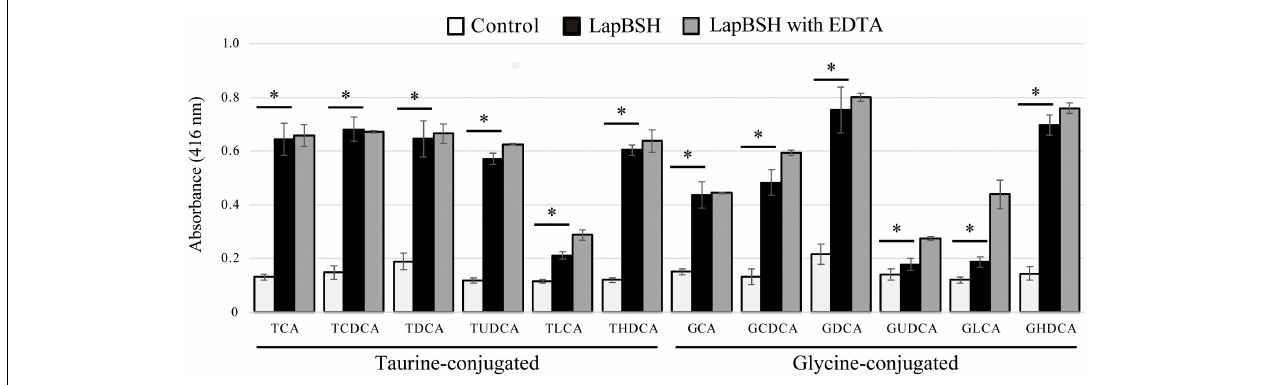
FIGURE 1 | Bile salt hydrolase (BSH) activity and substrate specificity of LapBSH. The tested substrates were glycocholic acid (GCA), glycochenodeoxycholic acid (GCDCA), glycodeoxycholic acid (GDCA), glycoursodeoxycholic acid (GUDCA), glycolithocholic acid (GLCA), glycohyodeoxycholic acid (GHDCA), taurocholic acid (TCA), taurochenodeoxycholic acid (TCDCA), taurodeoxycholic acid (TDCA), tauroursodeoxycholic acid (TUDCA), taurolithocholic acid (TLCA), and taurohyodeoxycholic acid (THDCA). Values represent the mean of three independent experiments (each n = 8). Error bars represent standard deviation (SD). ∗ A p -value less than 0.05 ( P < 0.05) was defined as statistically